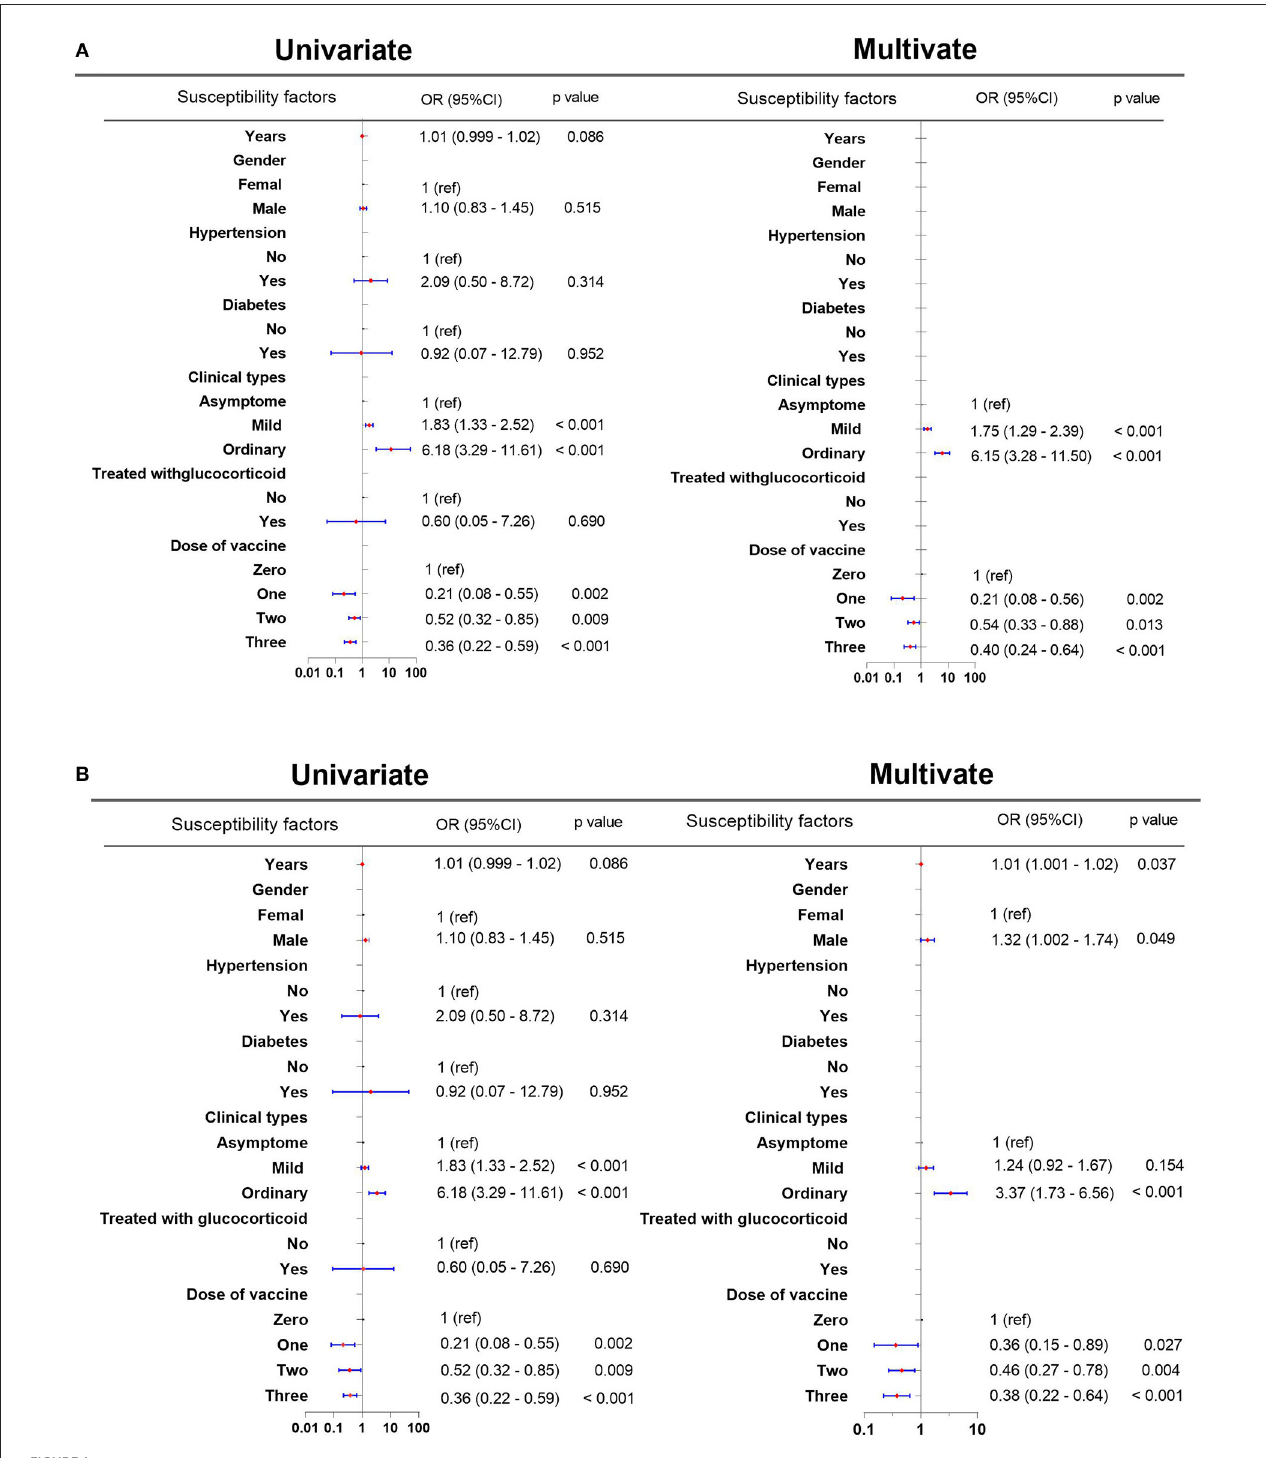
FIGURE1 Susceptibility factors associated with prolonged hospitalization and persistent virus in the sputum. (A) Susceptibility factors associated with prolonged hospitalization. (B) Susceptibility factors associated with the prolonged persistence of the virus in the sputum. CI, confidence interval; OR: odds ratio.